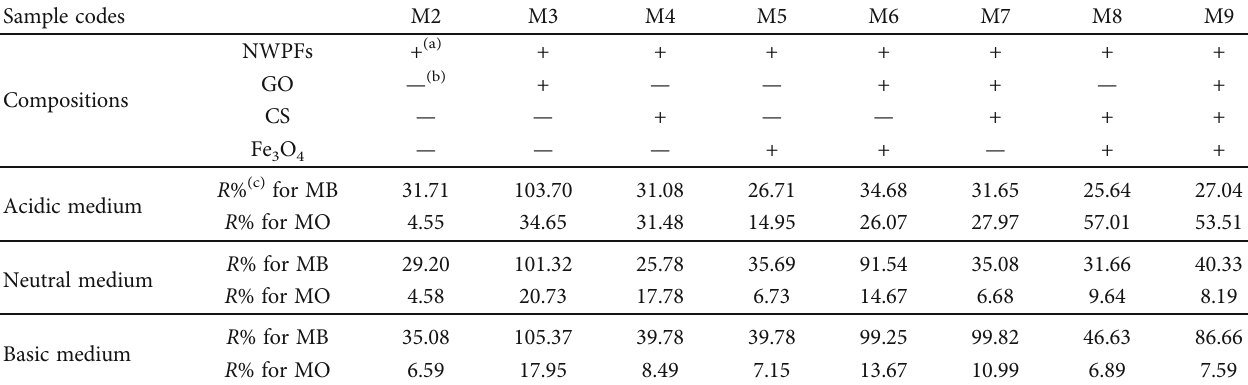
Table 1: Removal e ffi ciency ( R %) of MB and MO by various coated NWPF samples at di ff erent pH levels.